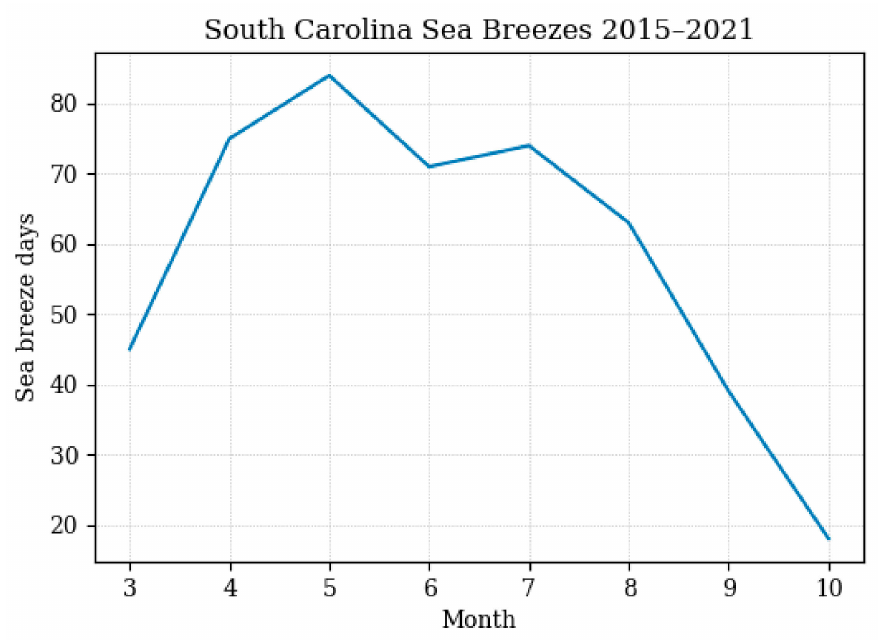
Figure 2. Frequency of verified sea breeze events by month in the period of